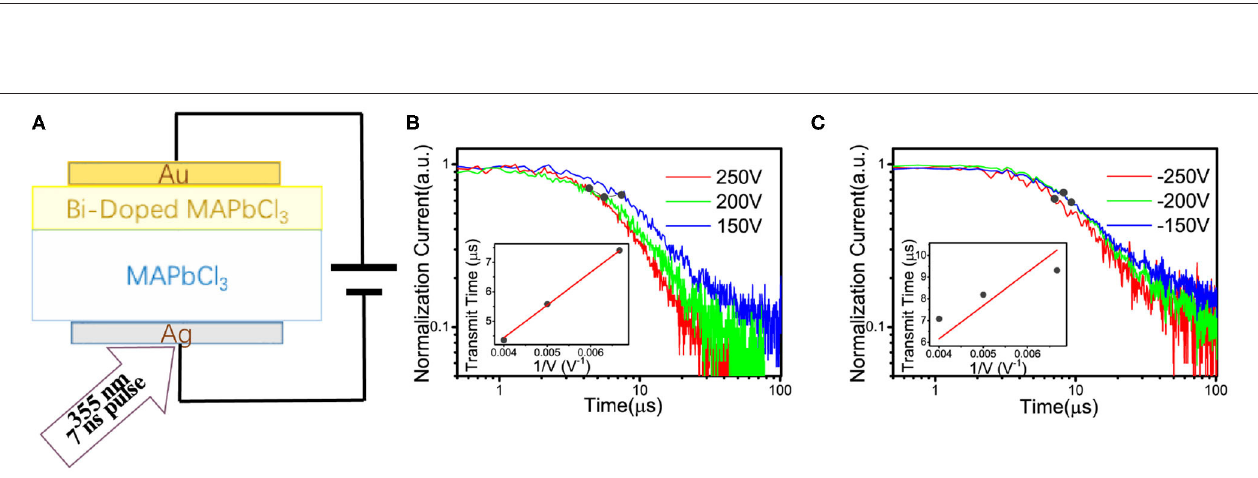
FIGURE 3 | (A) Illustration of the optoelectronic experiment. (B) Holes mobility measured by time-of-flight (TOF) method. (C) Electrons mobility measured by the TOF method.